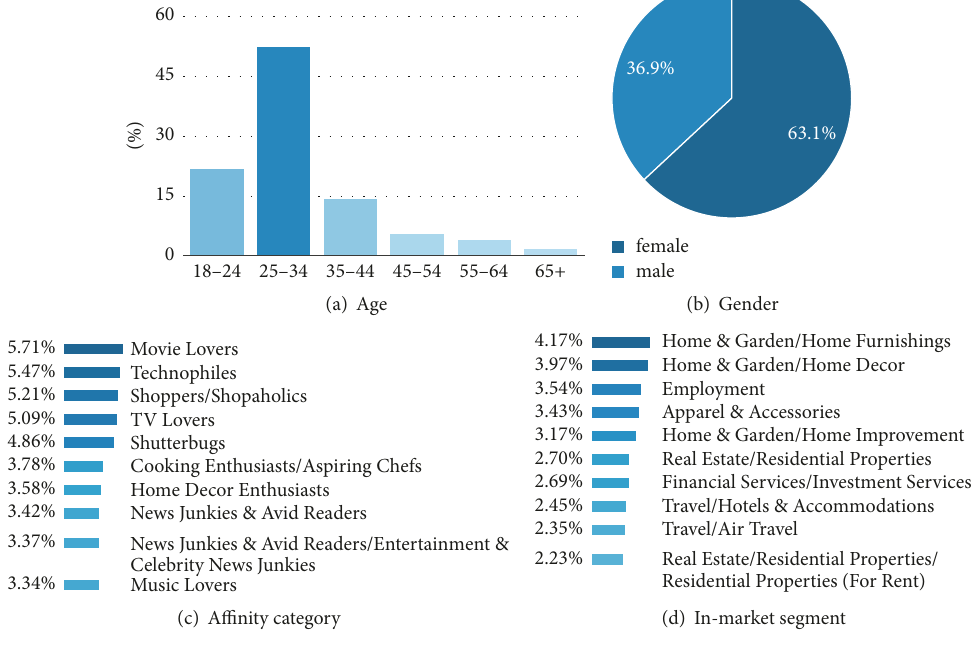
Figure 15: Consumer demographics.